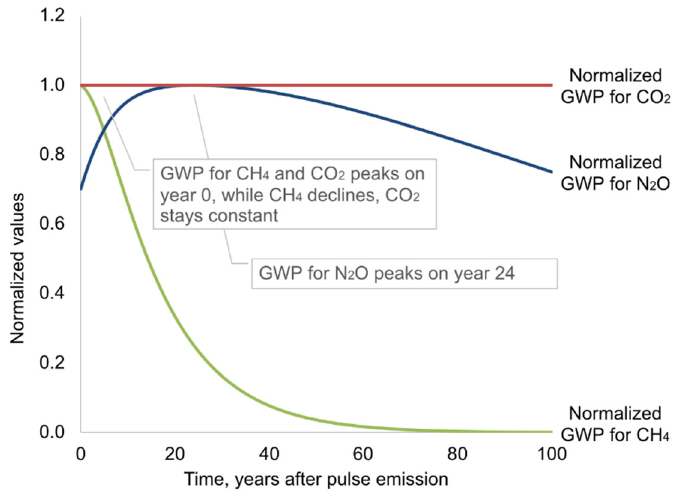
Figure 4. Normalized GWP values as a response to emission of CO 2 , N 2 O, and CH 4 at year zero. The values are normalized to the maximum value of the corresponding GWP of each gas, unitless.